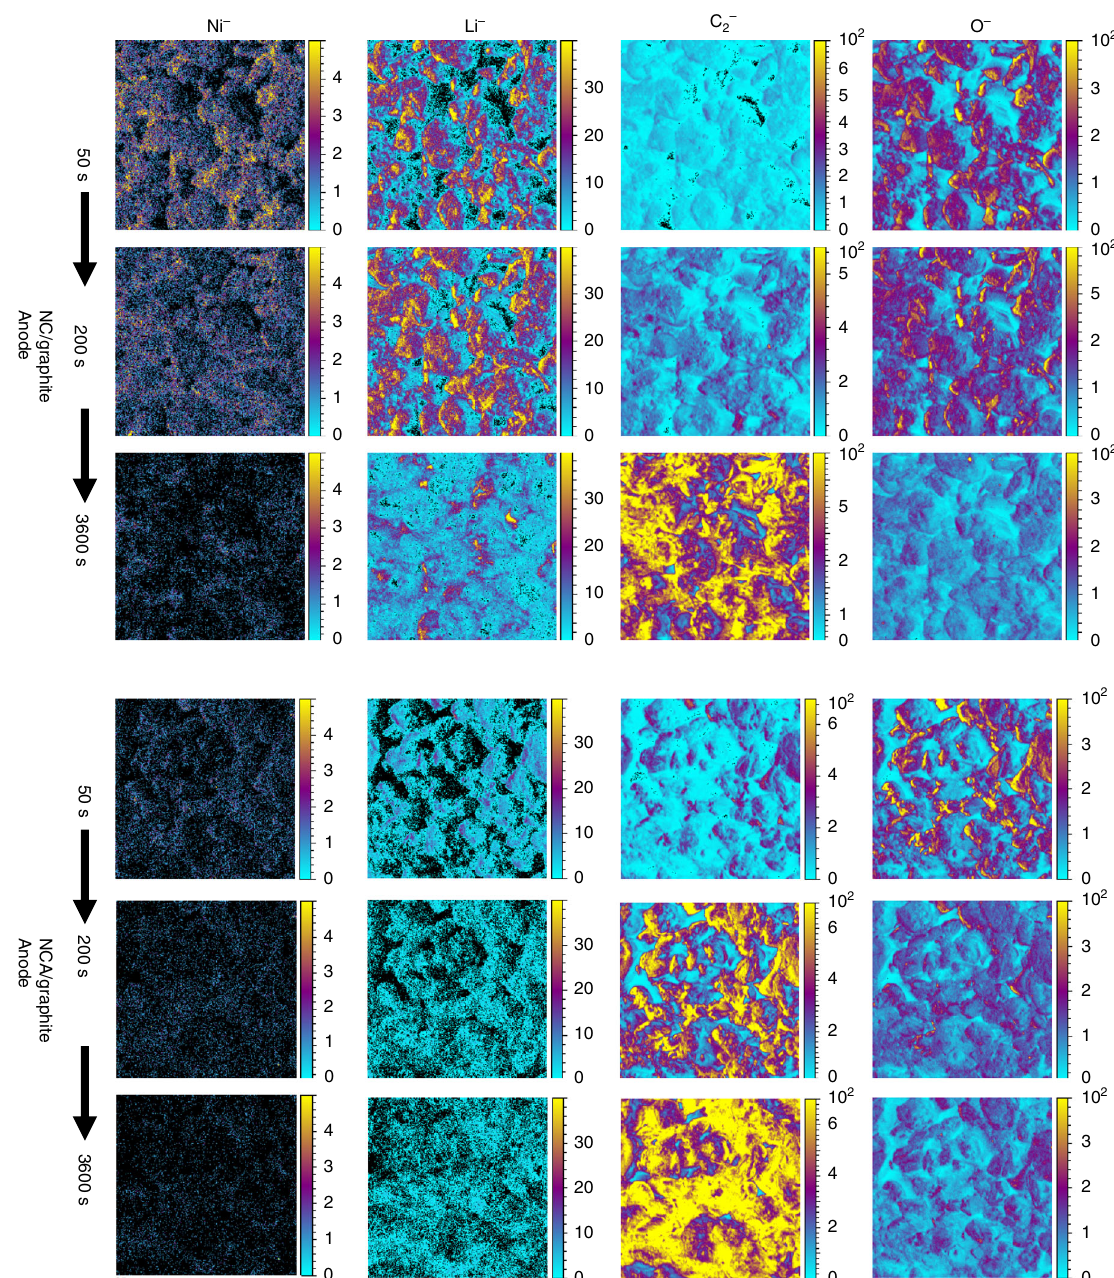
Fig. 6 Anode SEI properties of NCA/graphite and NC/graphite cells. The scale bar labels the concentration of each segment using different colors. Each of the 1st, 2nd, and 3rd horizontal row represents the surface compositional mapping after 50, 200, and 3600 s sputtering, respectively. The 1st – 4th vertical column represents the results of Ni − , Li − , C 2 − , O